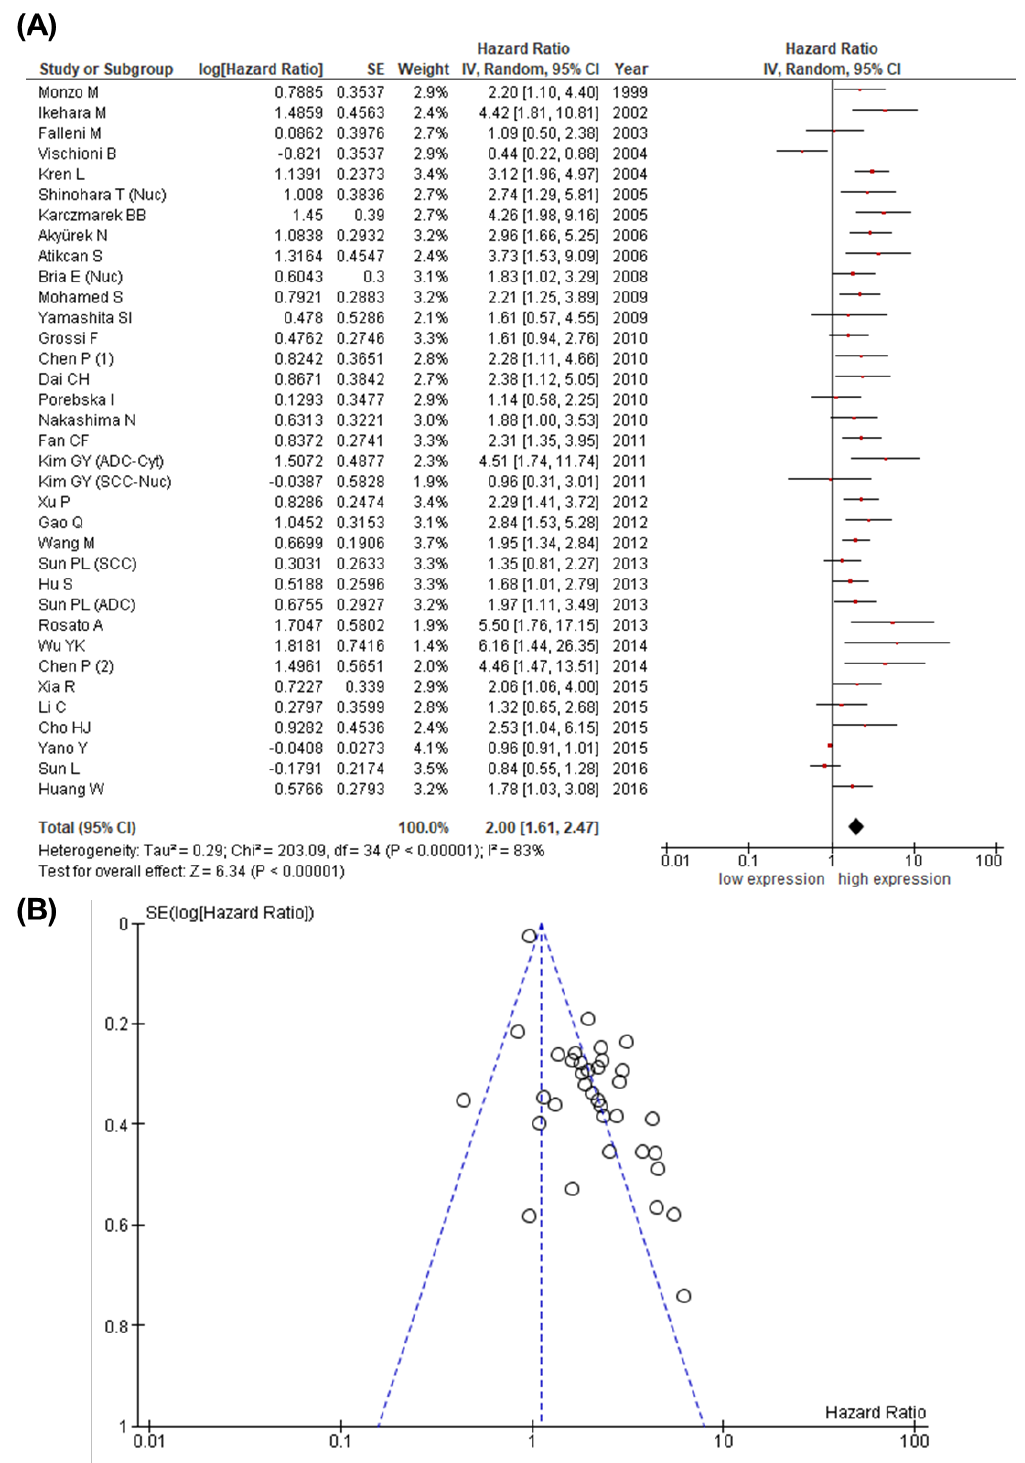
Figure 3. Meta-analysis comparing expression of survivin with OS in patients with lung cancer. ( A ) The forest plot reflects the individual and pooled HR with 95% CI. Heterogeneity was measured by the Cochrane Q test (Chi-squared test; Chi 2 ) and inconsistency (I 2 ). ( B ) The funnel plot demonstrates an asymmetric distribution. The Y -axis represents the standard error (SE), and the x -axis represents the study ’ s result.